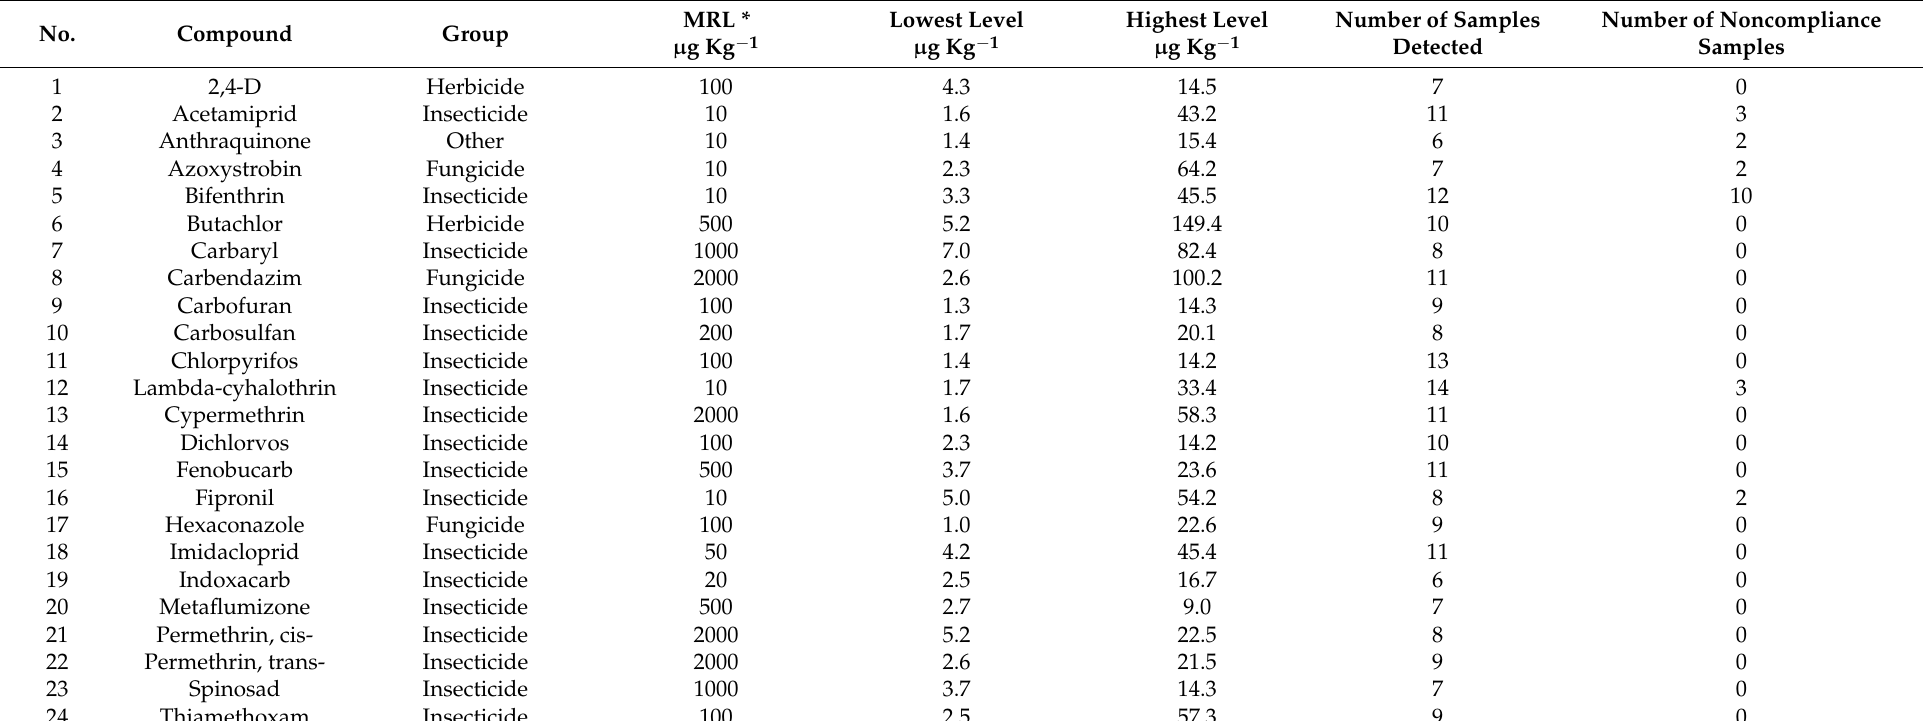
Table 3. Results of pesticide detection in commercial rice samples collected from markets in Hanoi,